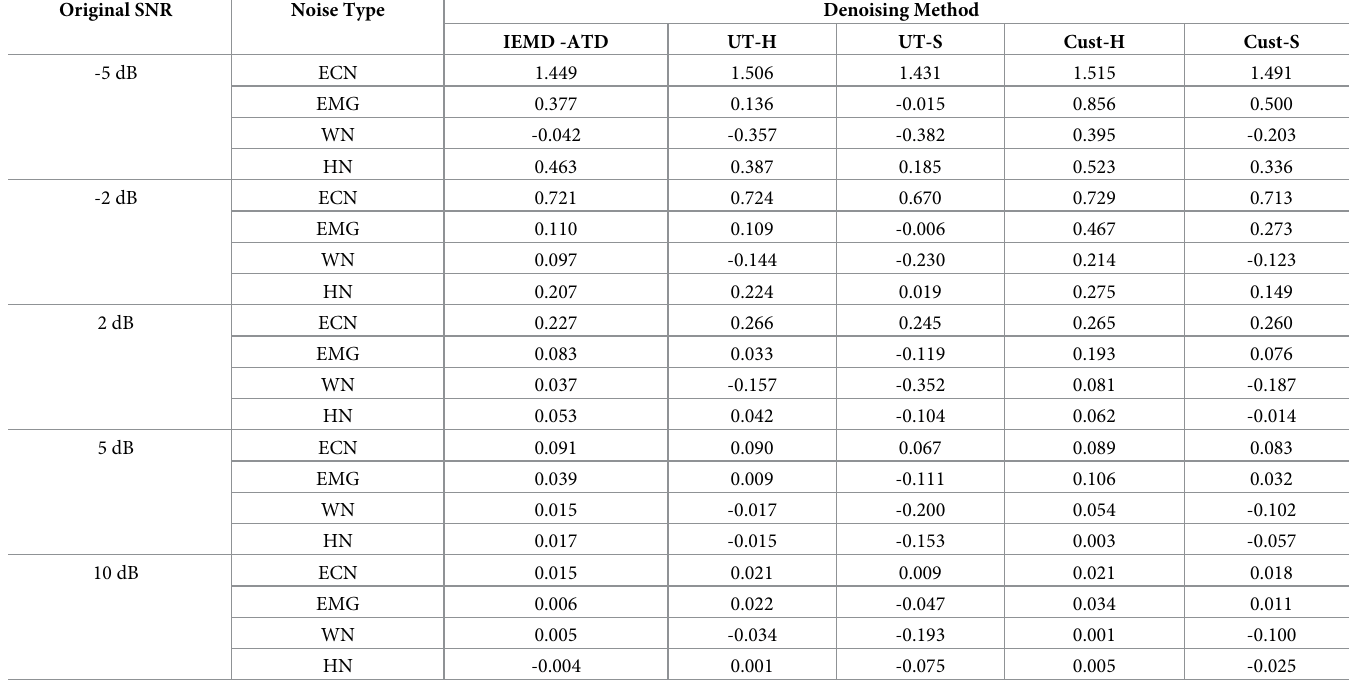
Table 9. Average relative differences in signal energy of 6 synthetic ECGs